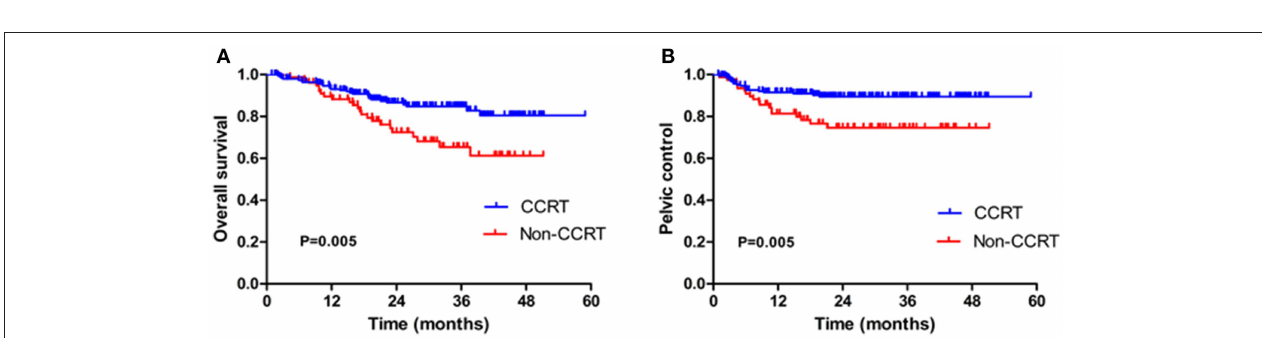
FIGURE 3 | Kaplan-Meier estimated of the overall survival (OS) (A) and pelvic control (PC) (B) in locally advanced cervical patients (stage IIB-IVB) in VMAT group with concurrent chemoradiotherapy (CCRT) or without CCRT (Non-CCRT).